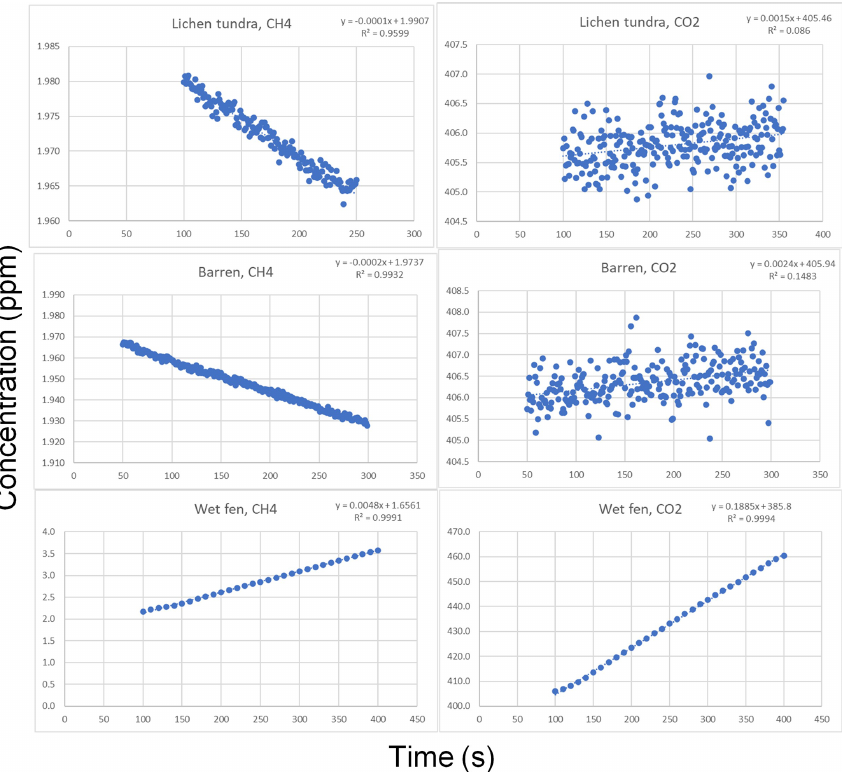
Figure A2. Examples of gas concentration variations during chamber closures measured using the gas analyzer (DLT-100, Los Gatos Re- search, Inc., San Jose, CA, USA). The examples represent lichen tundra, barren, and wet